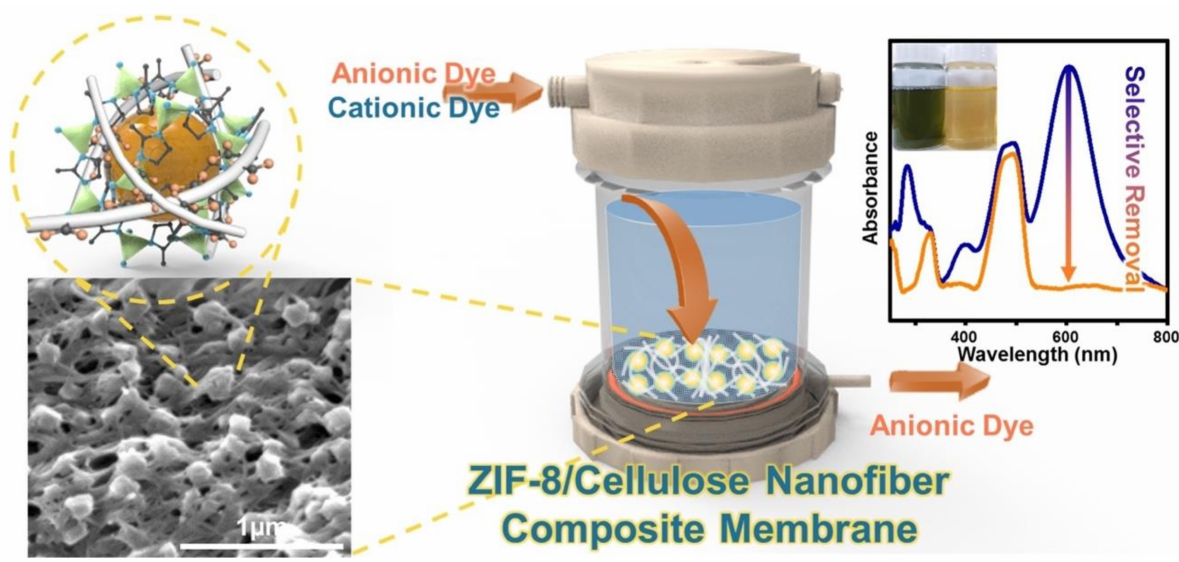
Figure 12. Control of the cellulose nanofibrous composite membrane structure by in-situ synthesis of zeolitic imidazolate framework-8 (ZIF-8) at cellulose nanofibers (CNF) for the selective removal of cationic dyes [235], © Elsevier,